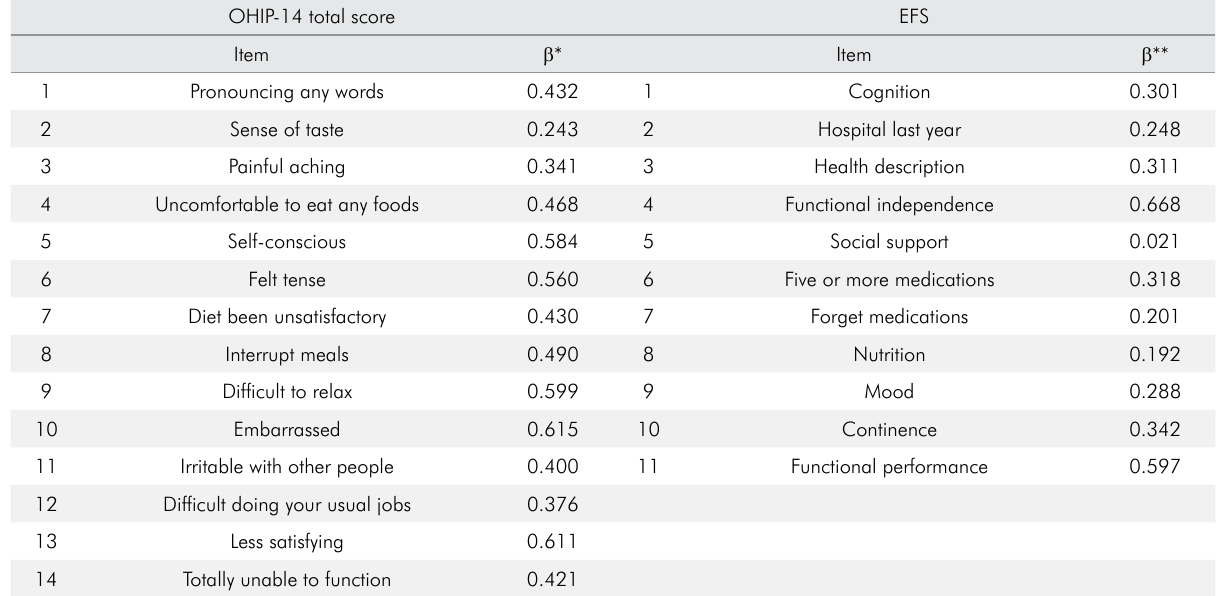
Table 2. Confirmatory factor analysis of each OHIP-14 total score and EFS multidimensional